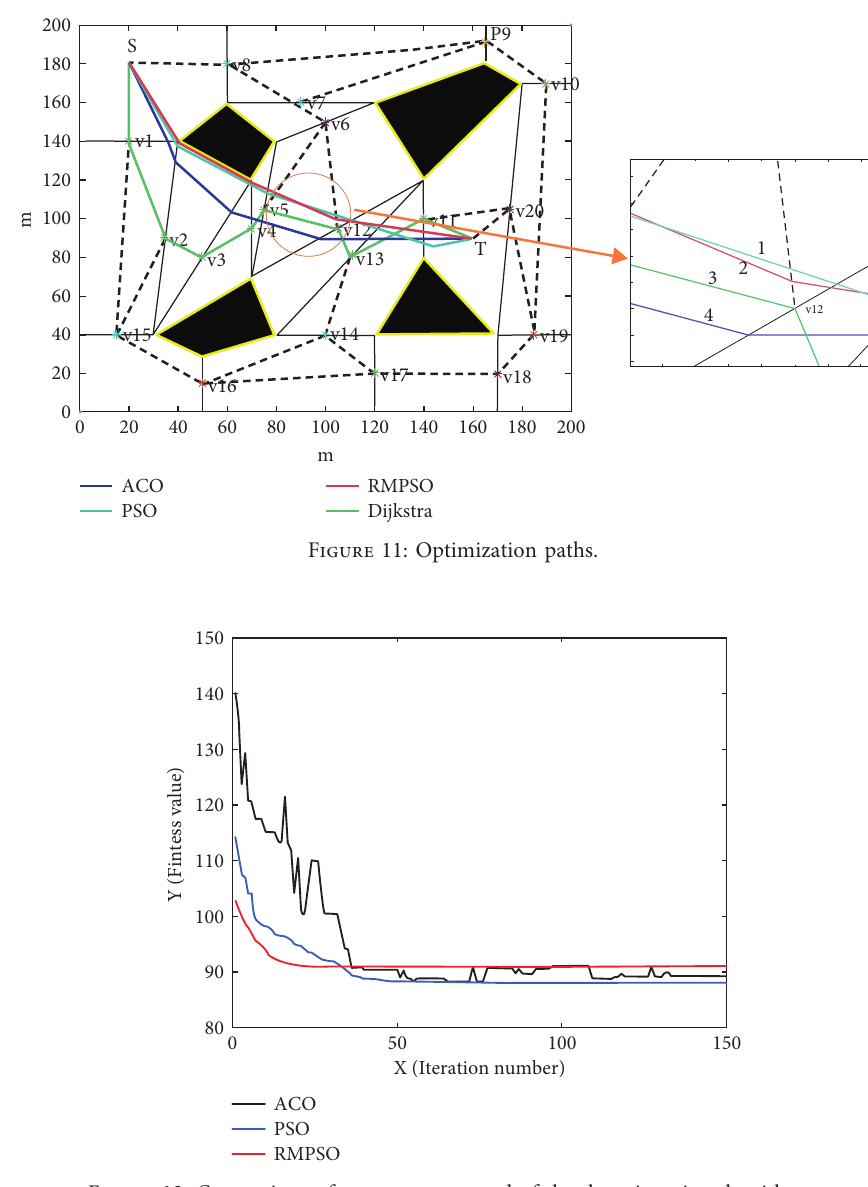
Figure 12: Comparison of convergence speed of the three iterative algorithms. Table 1: Comparison of convergence speed of the optimization algorithms.